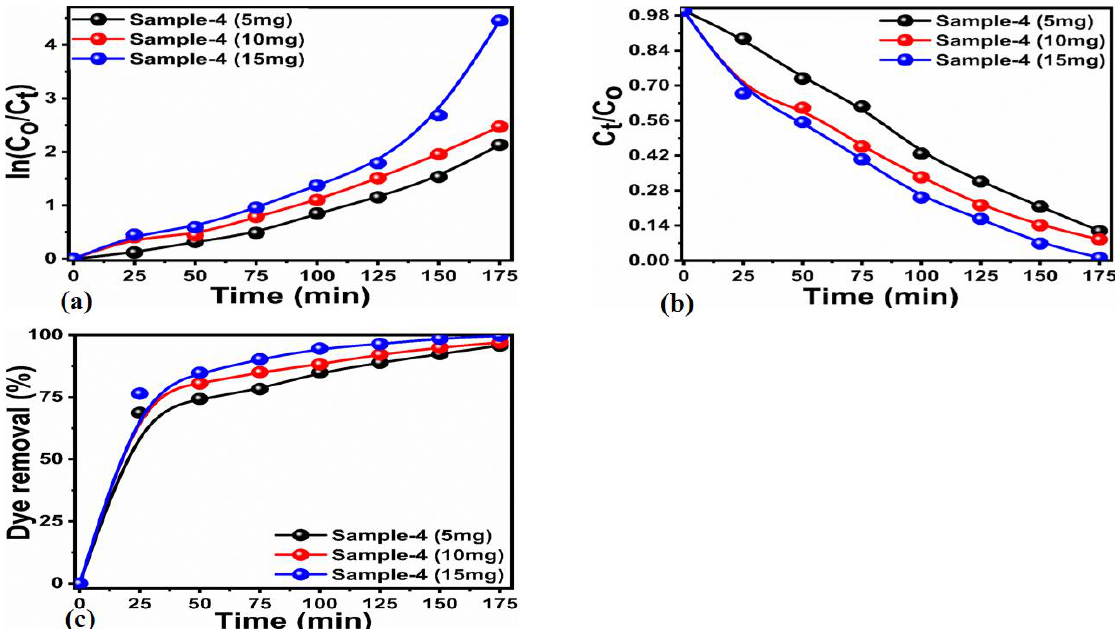
Figure 12. Photodegradation kinetics of 6.12 × 10 −5 M) MB solution with various catalyst doses of 5 mg, 10 mg, and 15 mg of sample-4 under irradiation of natural sunlight ( a ) Linear plot of ln( C t / C o ) against corresponding time of 175 min. ( b ) Linear plot of C t / C o . ( c ) Various pH-dependent degradation efficiency of MB solution.